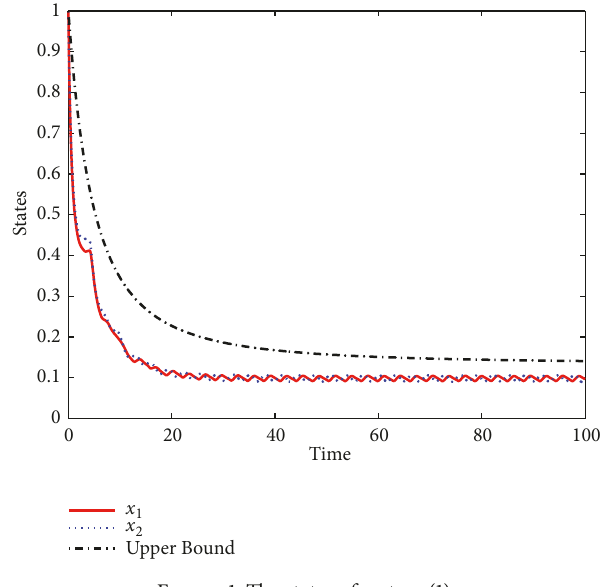
Figure 1: The states of system